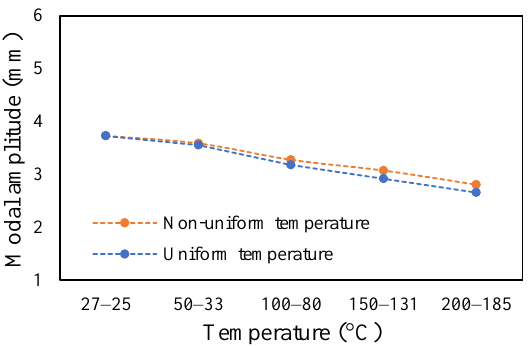
Figure 26. Comparison of modal amplitude of 1 mm crack depth ramped at 2 °C/min.